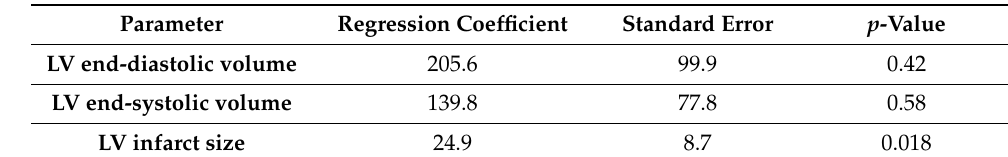
Figure 3. Kaplan–Meier curve for embolic events for the patients with LV thrombus detected by LGE-CMR (red line) and Figure 3 . Kaplan – Meier curve for embolic events for the patients with LV thrombus detected by the patients who did not discover LV thrombus by LGE-CMR (blue line). LGE - CMR ( red line ) and the patients who did not discover LV thrombus by LGE - CMR ( blue Table 2. Multivariate Cox Regression analysis of LV thrombus. line ).